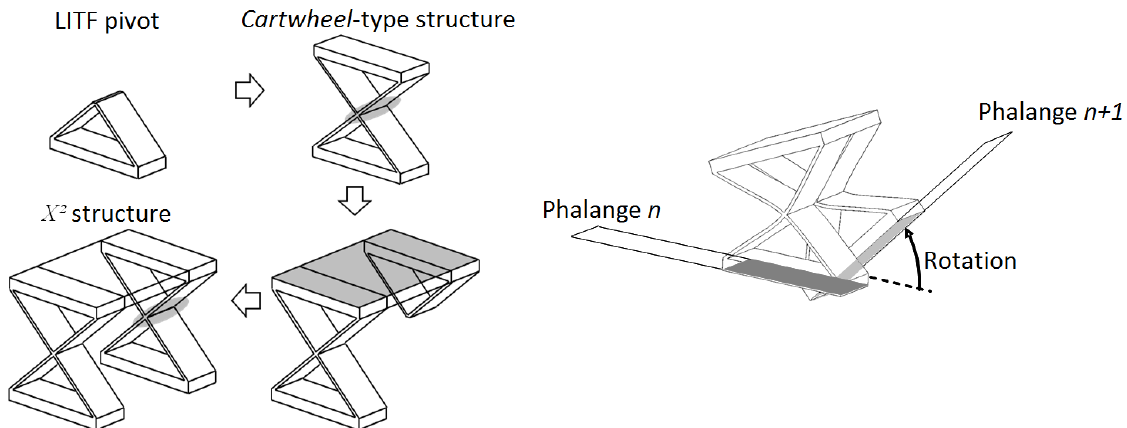
Figure 8. Design and rotational motion produced by the X 2 pivot between two successive phalanges of a gripper